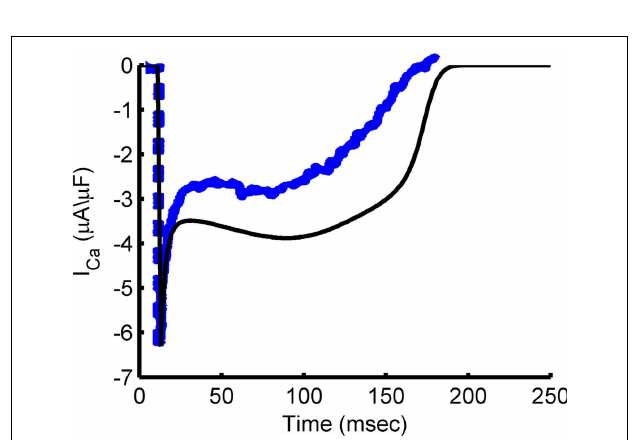
brief peak aligned with the initial AP depolarization followed by a slow peak during the AP plateau. RyR flux (F) increases slowly and reaches its maximum in parallel with the J LCC slow peak and AP plateau. Dashed lines in (C,F) correspond to the time of Ca 2 + transient peak from (D) . Flux measurements are given with respect to subspace volume. (B,E) Were reproduced with copyright permission fromThe Physiological Society.